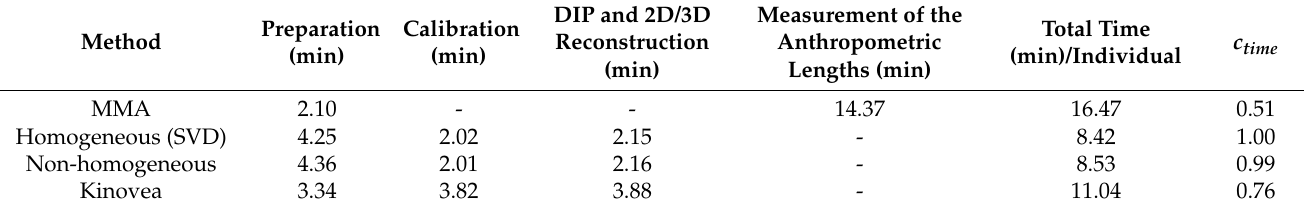
Table 8. Average time required by each method to measure a